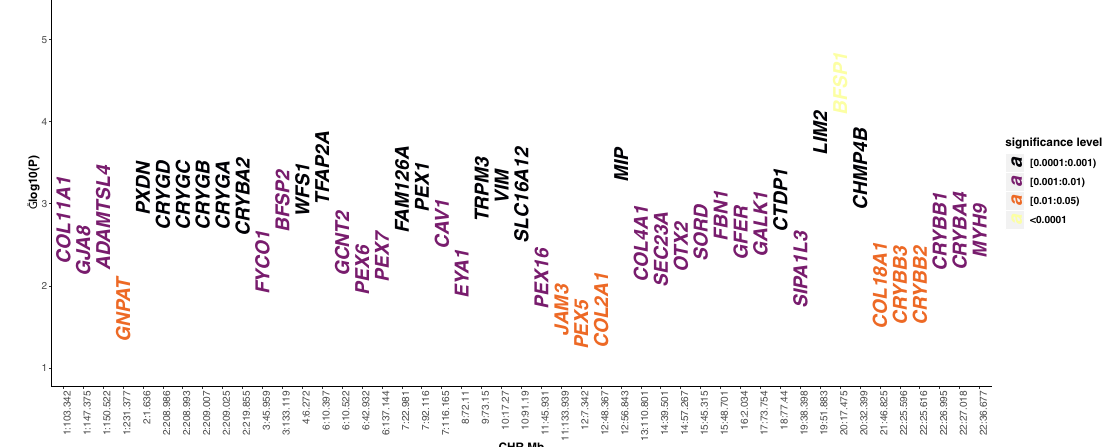
Fig. 2 Common variants in congenital cataract genes. This Manhattan plot shows the association results for the congenital cataract genes. The − log10 ( P value) of the most strongly associated variant per gene is plotted against the gene location (in chromosome followed by mega base format: CHR.Mb). The colour code represents the strength of association in terms of P for multiple testing ( α = 5 × 10 − 4 ) in BFSP1 ( β = 0.08; P = 3.5 × 10 − 5 ), LIM2 ( β = 0.04; P = 1.4 × 10 − 4 ), MIP ( β = 0.02; P = 3.4 × 10 − 4 ), TFAP2A ( β = 0.05; P = 3.7 × 10 − 4 ) and CHMP4B ( β =